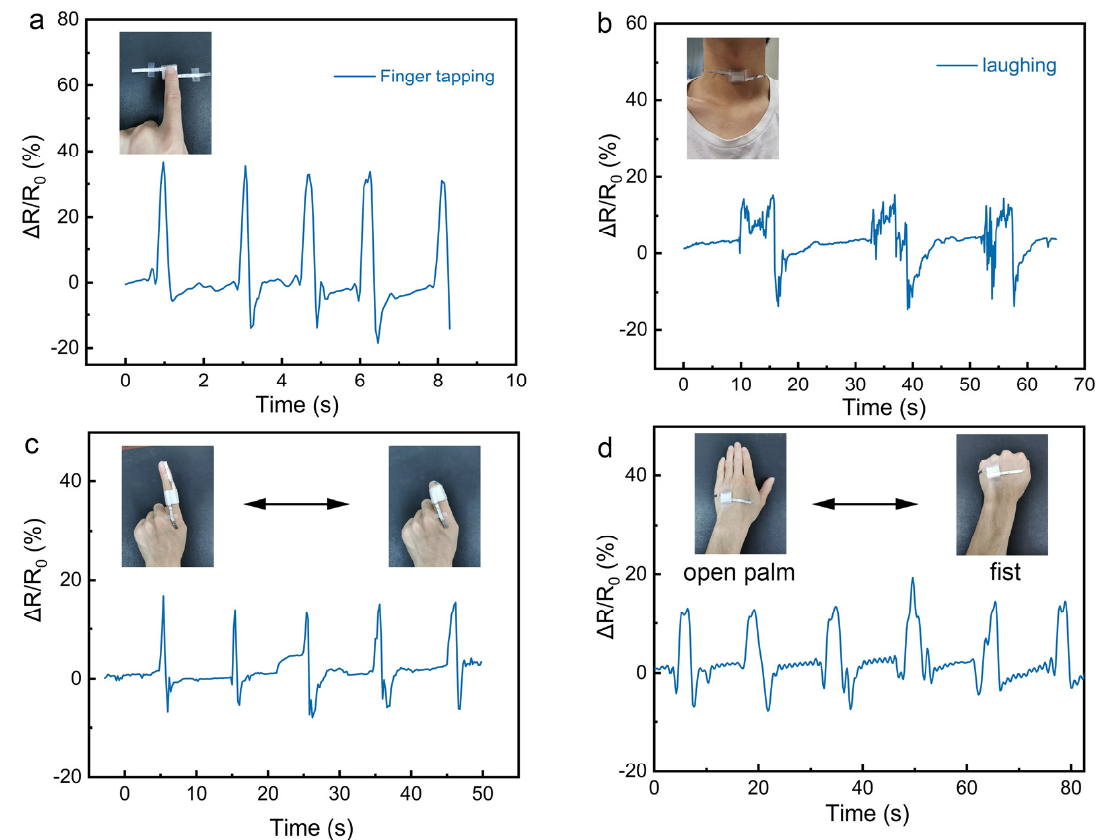
Figure 6. Applications of the electrospun PU film-based pressure sensor to human motion detection. Real-time signal of the pressure sensor in monitoring motions of ( a ) finger tapping, ( b ) laughing, ( c ) finger bending, and ( d ) a posture of a human hand. The insets are the photos of the tester wearing the pressure sensor.